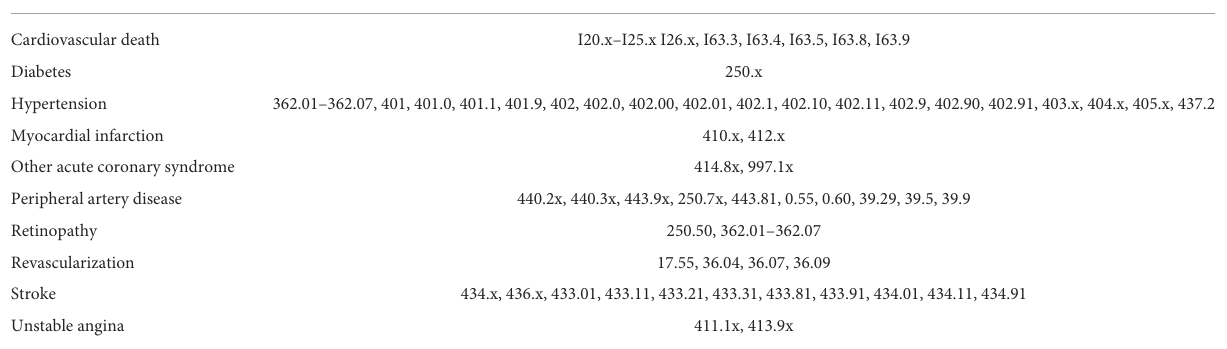
TABLE 1 ICD-9-CM and ICD-10 codes to define conditions of